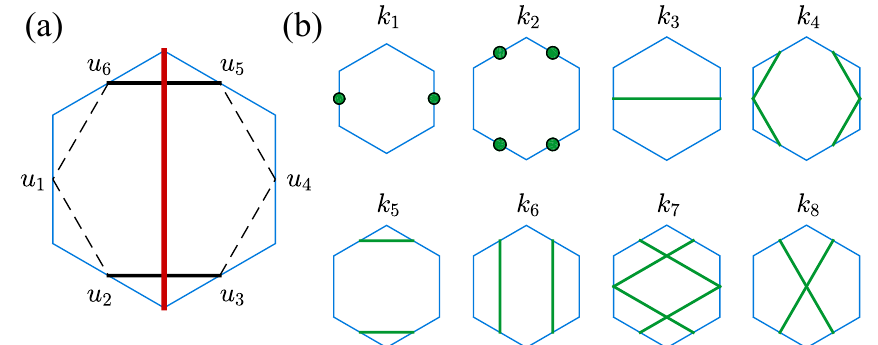
Figure 5: (a) The coarse-grained variables u describing the displacements of the i facets. (b) For a hexagonal building block, symmetries allow eight different inter- action constants between pairs of facets. The interacting facets are indicated by a connecting line, or by a circle for the diagonal